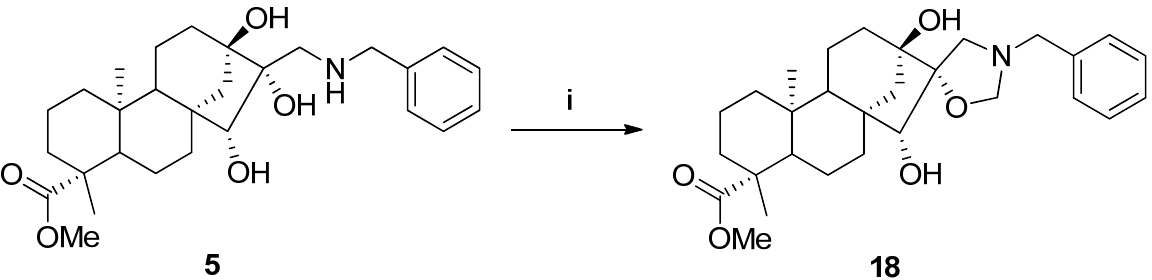
derivatives on human cancer cell lines was observed [32,33]. Intrigued by our previous re- sults, we decided to synthesise the heterocyclic counterpart of compound 5 and determine the regioselectivity of ring closure. Treatment of aminotriol 5 with aqueous formalde- hyde at room temperature gave spiro-oxazolidine 18 in an exclusive manner in a highly regioselective reaction (Scheme 3).